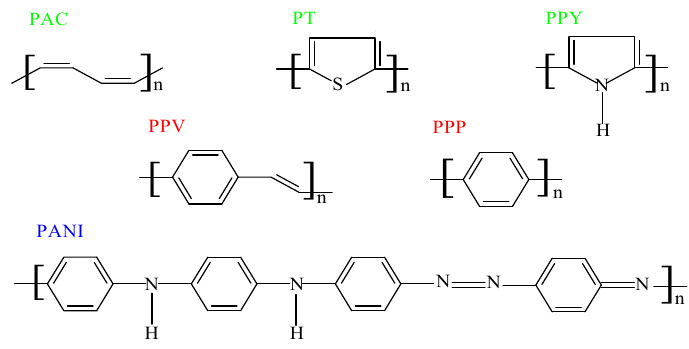
Figure 1. The chemical structures of the chosen conducting polymers.